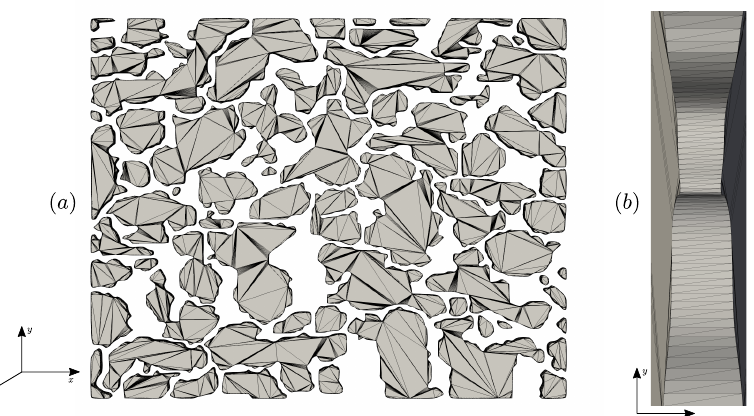
Figure 19. STL triangulation of the sandstone rock used in the simulations: ( a ) xy view and ( b ) yz view showing a single triangle in the z